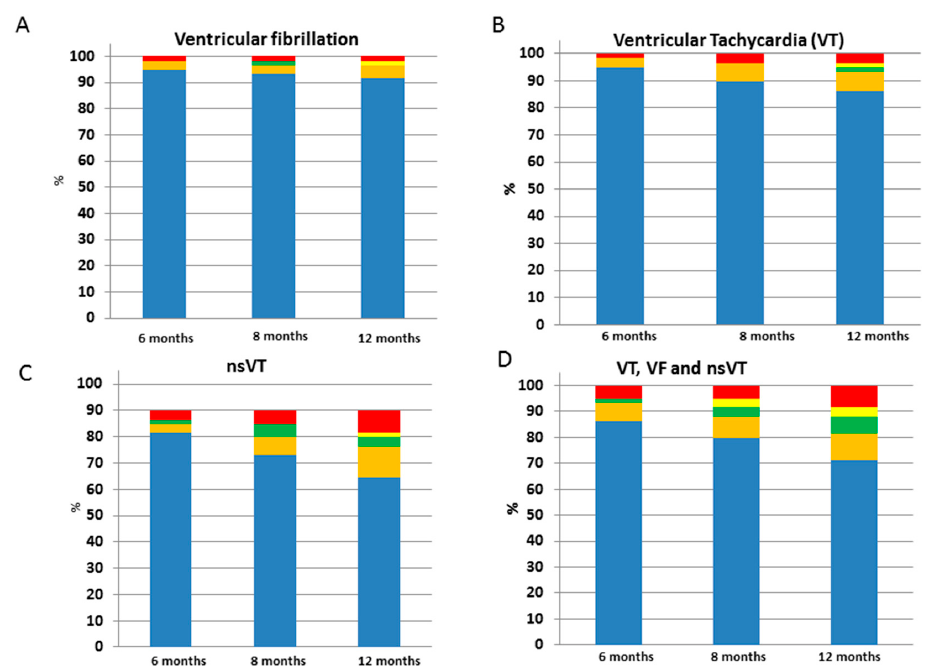
Figure 2. Comparison of ventricular arrhythmias before and after initiation of sacubitril/valsartan ( A ) Ventricular fibrillation (VF), ( B ) Ventricular tachycardia (VT), ( C ) Non-Sustained VT (nsVT), ( D ) A composite of VT, VF and nsVT. Red, more than 3 events; Yellow, 3 events; Green, 2 events; Orange, 1 event; Blue, no events.